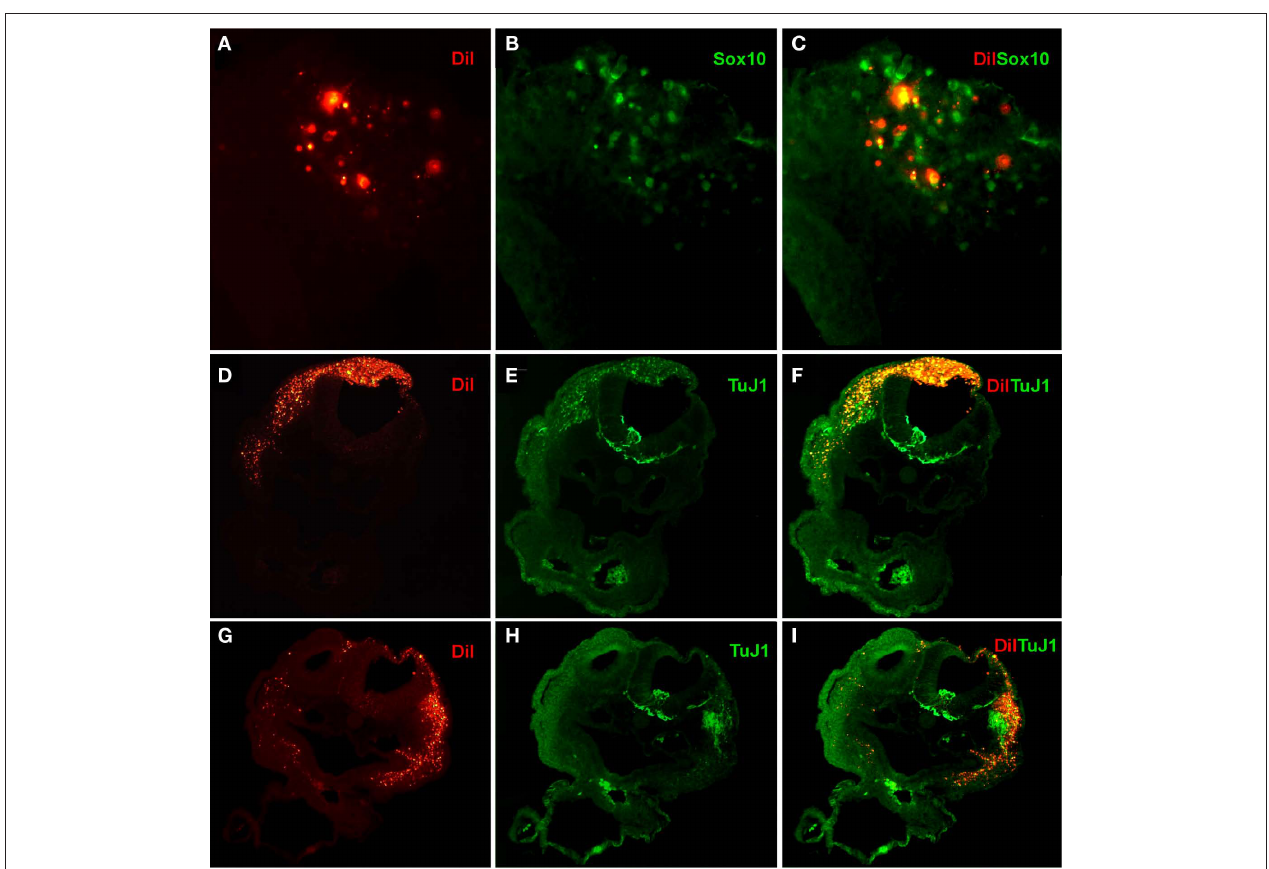
rise to migrating NCCs as evidenced by DiI labeling (D,g) which colonize the entire proximo-distal extent of the first and second branchial arches respectively (D,g) . Tuj1 immunostaining (e,H) revealed the neurogenic potential of neurosphere-derived NCCs by demonstrating that a subpopulation of the proximally located cells contribute to the trigeminal (D–F) and facial (g–i) ganglia